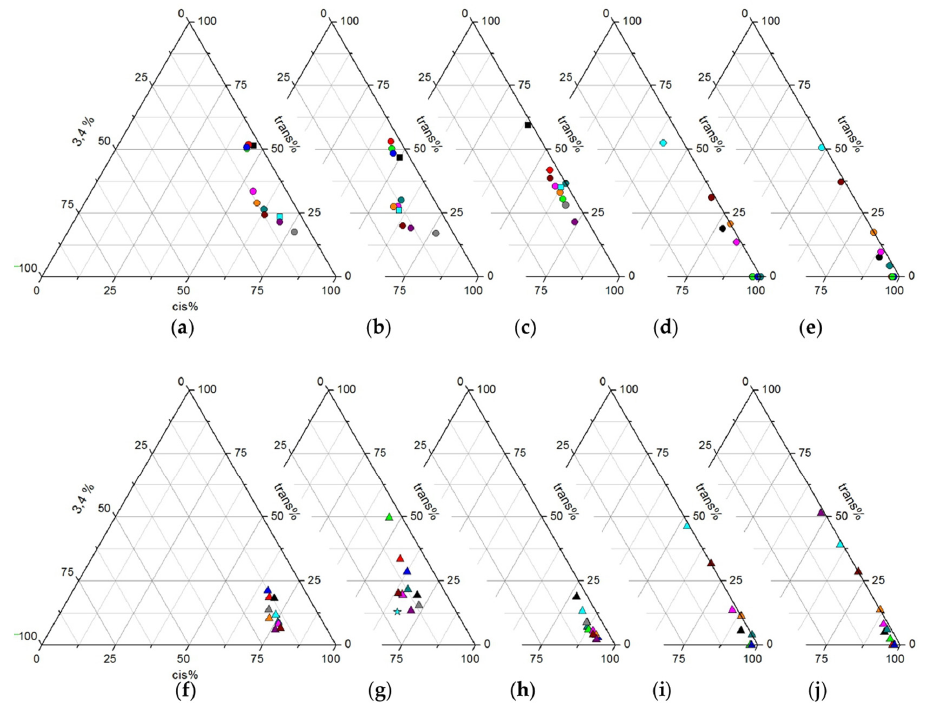
Figure 2. Ternary diagrams representing the microstructure of the polyisoprenes obtained from Ln(AlMe 4 ) 3 ( 2 Ln ). Panels ( a – j ) give details on the selectivity obtained by the application of a certain cocatalyst ( A – E ( a – e ) and 2 equiv. of A – E ( f – j ); A = [Ph 3 C][B(C 6 F 5 ) 4 ], B = [PhNMe 2 H][B(C 6 F 5 ) 4 ], C = B(C 6 F 5 ) 3 , D = Me 2 AlCl, E = Et 2 AlCl). Results for the addition of 1 equiv. of cocatalyst per 2 Ln after 1 h are shown by circles, 2 equiv. by triangles. If such results were not available, microstructures of reaction times of 24 h are shown marked with squares and stars, respectively. Complexes 2 Ln are color-coded regarding the Ln as follows: black (La), red (Ce), green (Pr), blue (Nd), teal (Gd), pink (Tb), orange (Dy), brown (Ho), cyan (Y), violet (Er) and grey (Lu). For a more traditional compilation of the polymer data in table form, sorted by precatalyst, see Tables S1.2.1—S1.2.11, Supplementary Materials.